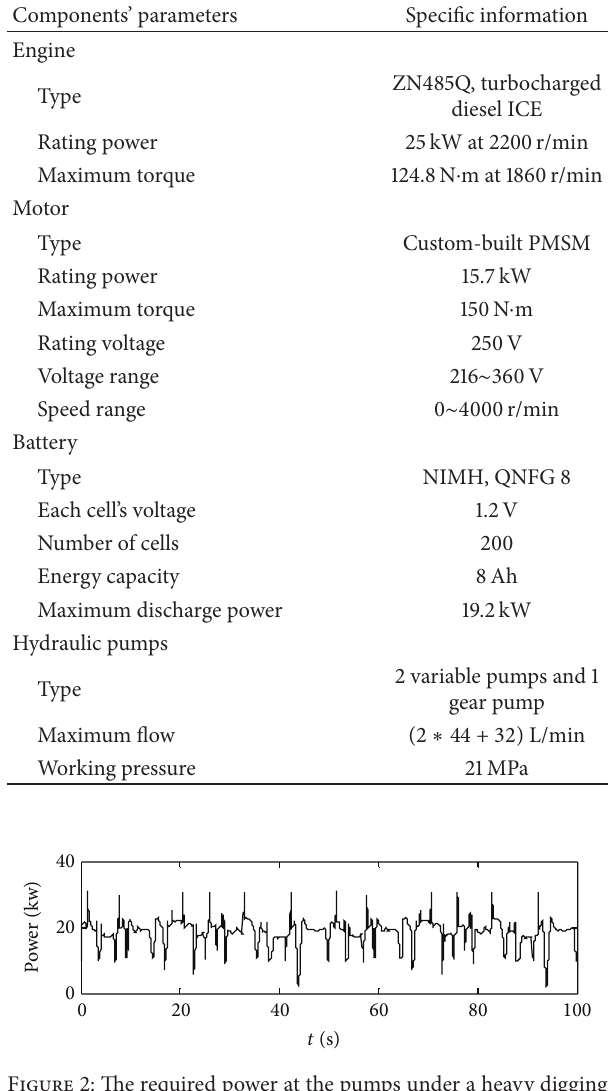
Figure 2: The required power at the pumps under a heavy digging cycle.